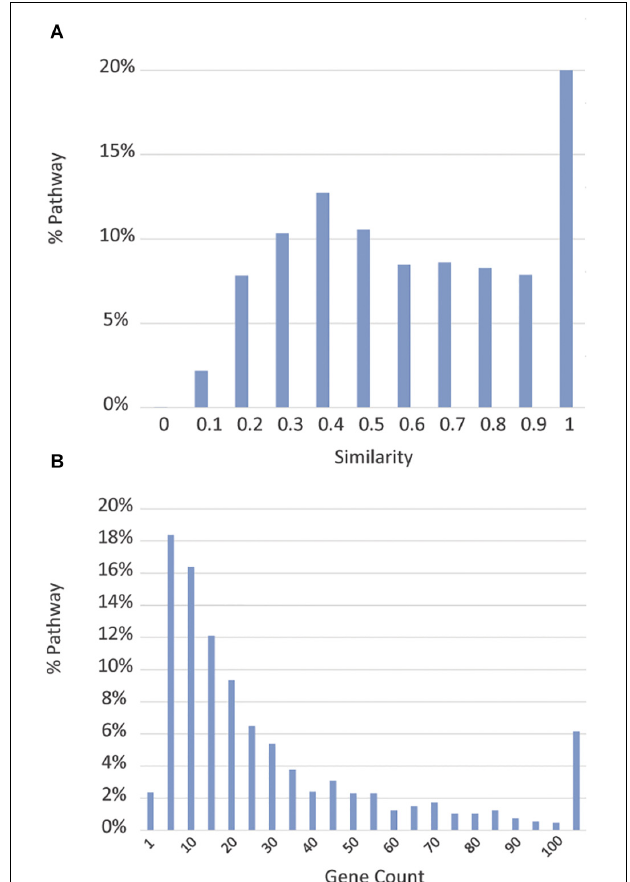
FIGURE 2 | Overview of source pathways. (A) Distribution of similarity scores, measured by the degree of gene component overlap, of pathways from different databases. (B) Distribution of pathway sizes measured by gene